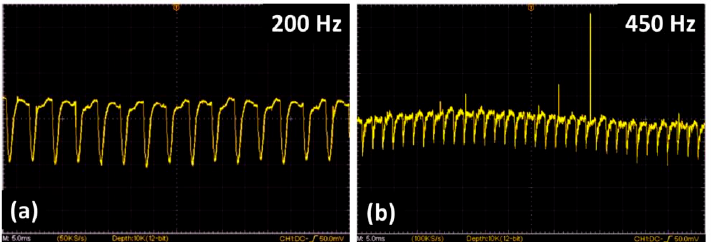
Figure 9. Dynamic behavior. Configuration Com 4 combines the high-resolution spatial shaping of the SLM and the fast-switching capability of the MEMS. The frequency response of combined SLM and Fresnel-mirror is shown as oscilloscope traces for two selected frequencies: ( a ) 200 Hz and ( b ) 450 Hz (time interval 75 ms in both cases). Far field oscillation was detected by a fast photodiode. At higher frequencies, the signal of the unscreened detector was slightly distorted by electromagnetic interference (laser source: diode laser, 790 nm).